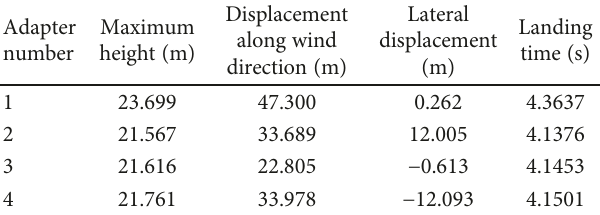
Figure 16: The aerodynamics of adapter